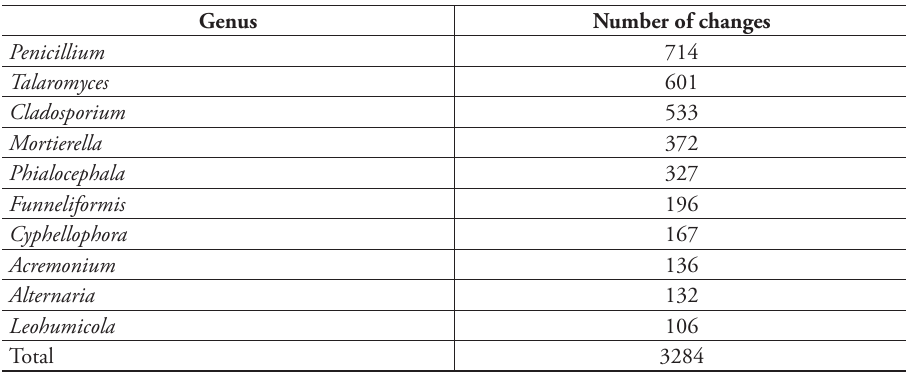
Table 1. Overview of genera. The 10 genera that saw the largest number of taxonomic changes during the workshop, plus the number of such changes.